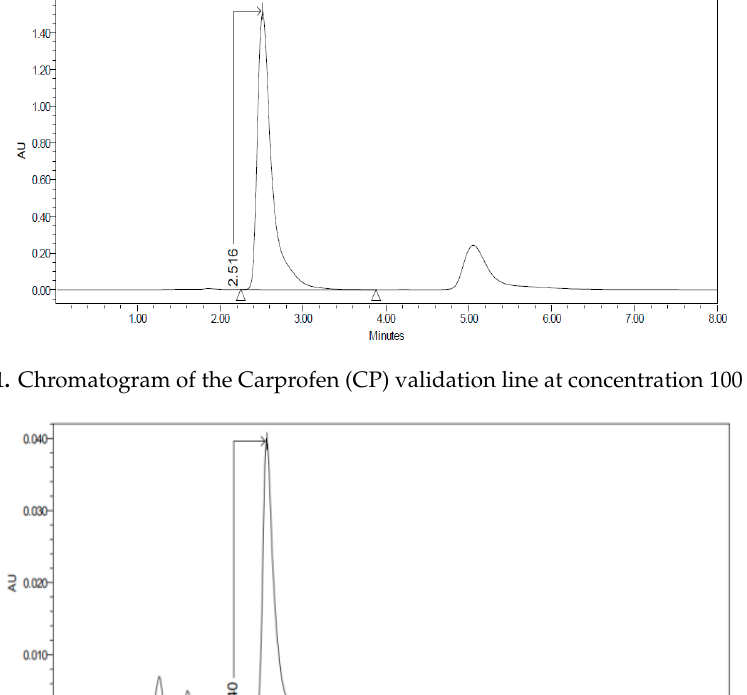
Figure 4. Chromatogram of CP-NPs in conjunctiva at 6 h.